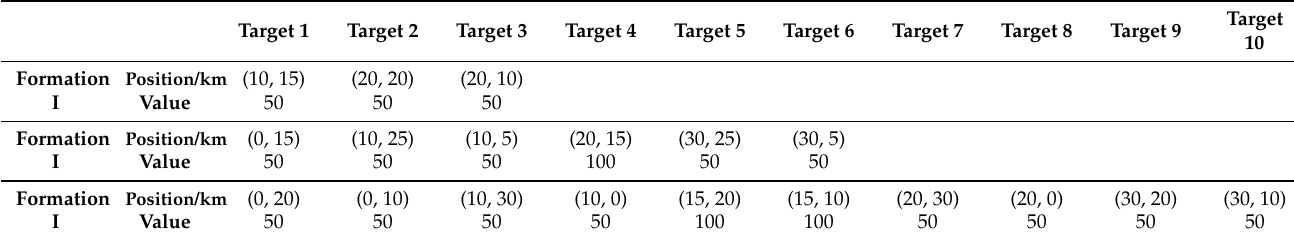
Table 2. Position and value information of the target formations.